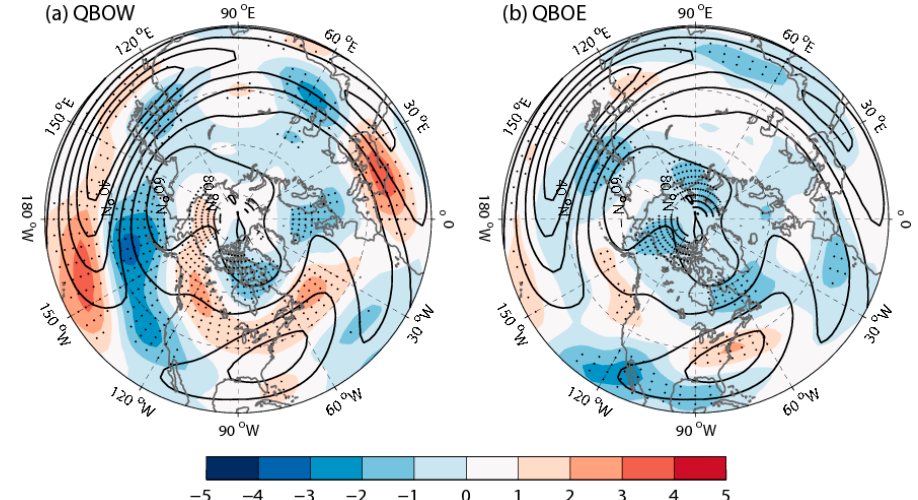
Figure 4. Composite zonal wind anomalies at 200 hPa (shading, m/s) averaged in QBOW ( a ), QBOE ( b ) years. The black contours denote the climatological zonal wind in winter. The black dots indicate anomalies significant at the 95% confidence level by Student’s t test.